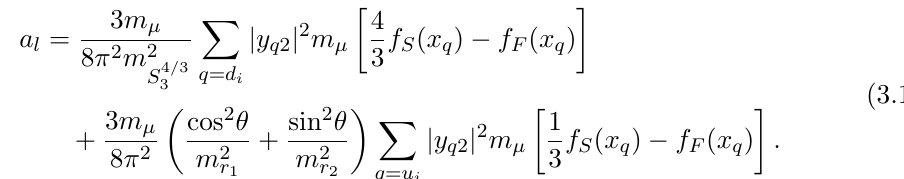
leptoquark and down-type 3